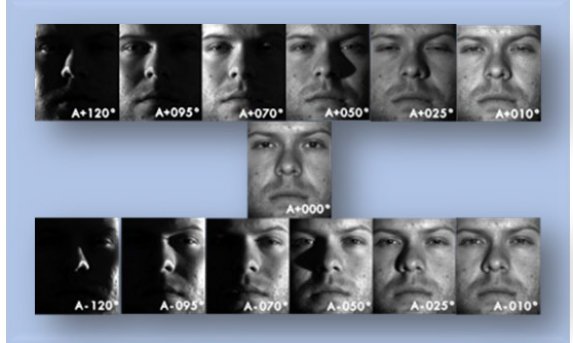
Figure 8. Grouped images of A+120--120E+00.